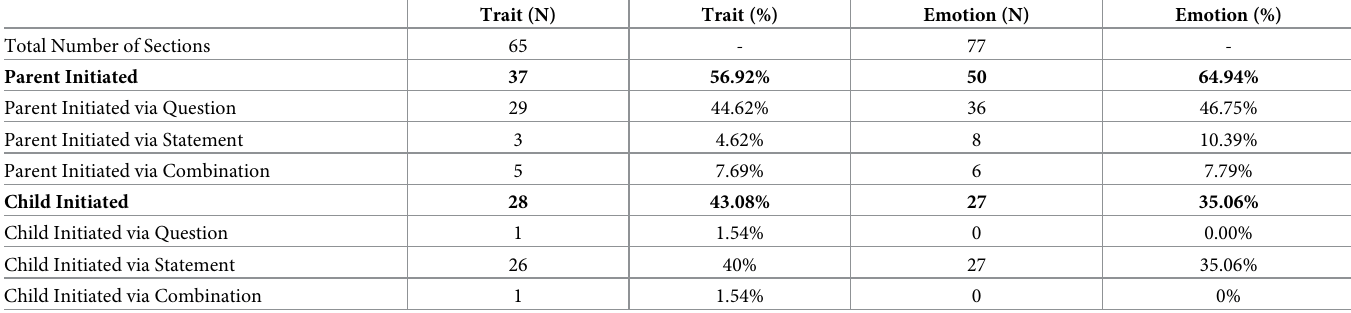
Table 3. Study 2: Descriptive statistics for the number of times conversation was initiated by the parent or child and the form of the initiation (question, statement or a combination of both) for trait and emotion discussion.